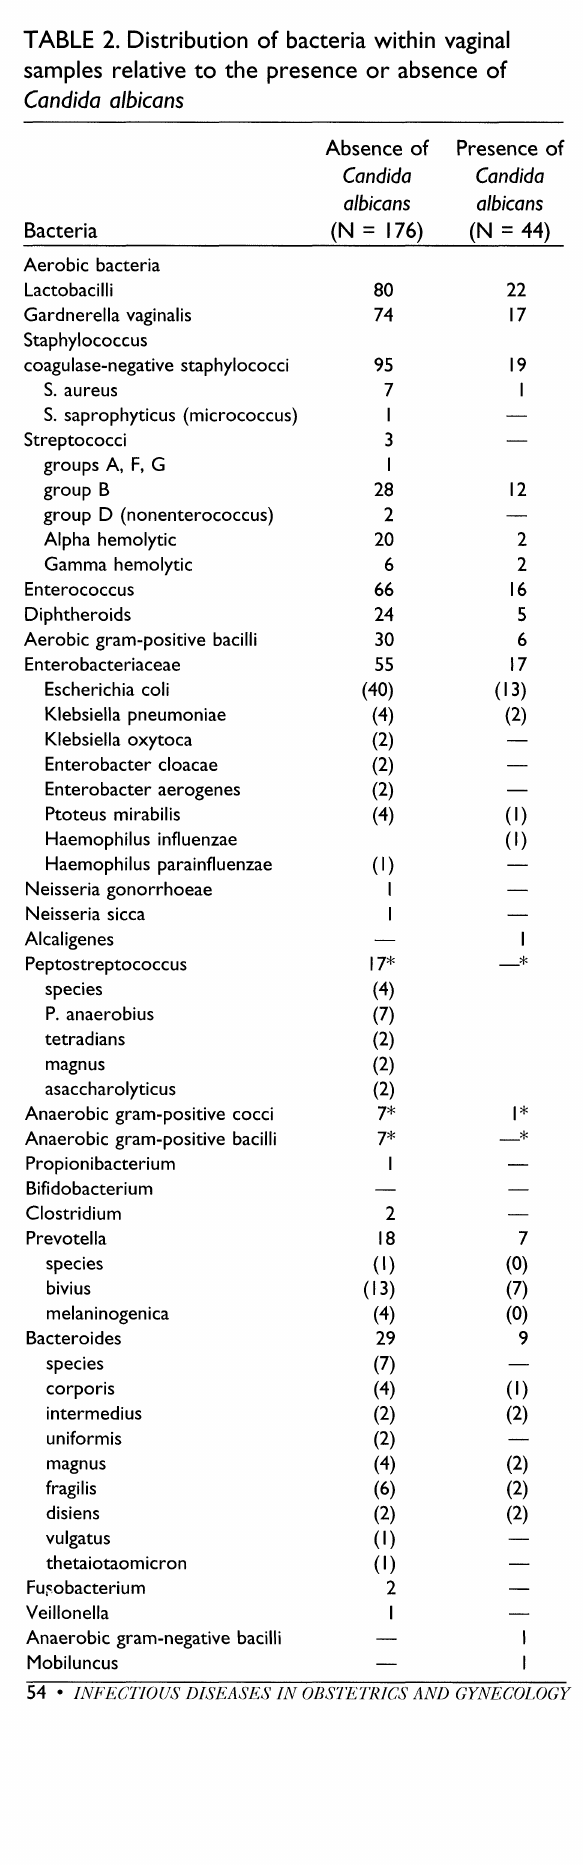
TABLE 2. Distribution of bacteria within vaginal samples relative to the presence or absence of Candida